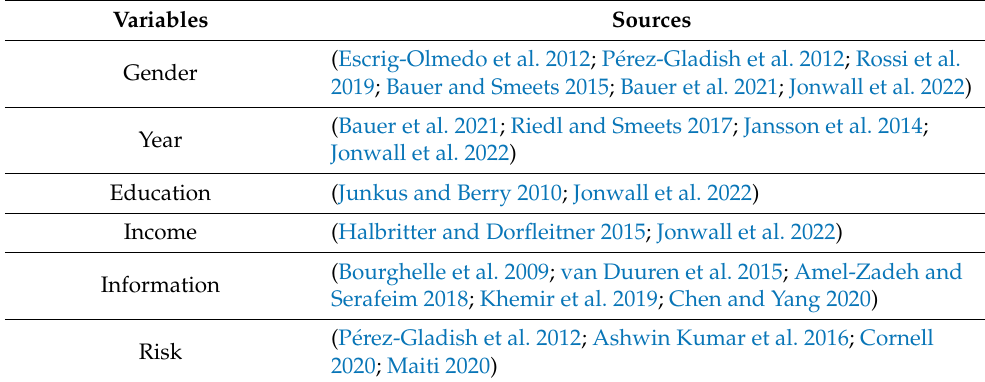
Table 1. The personal and sociodemographic variables influencing investment